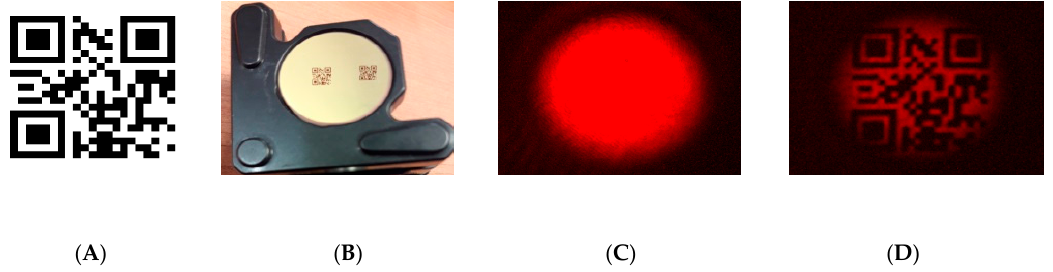
Figure 6. ( A ) QR data pattern used for spatial modulation. ( B ) Reflecting surface with printed 2D data. Up-converted beam images: ( C ) unmodulated and ( D ) modulated and read Figure 6. ( a ) QR data pattern used for spatial modulation. ( b ) Reflecting surface with printed 2D data. Up ‐ converted beam images: ( c ) unmodulated and ( d ) modulated and read out.